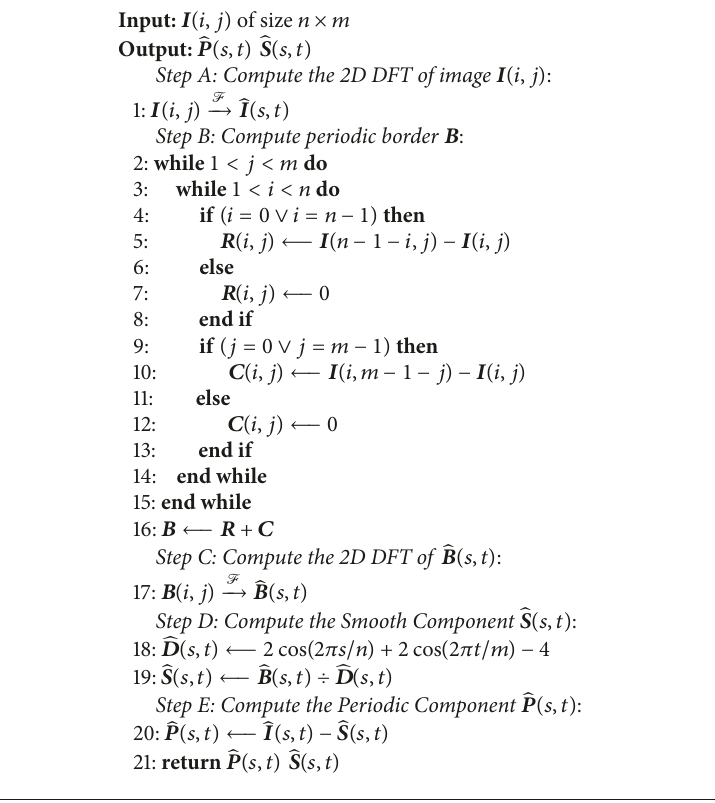
Algorithm 1: Periodic plus smooth decomposition